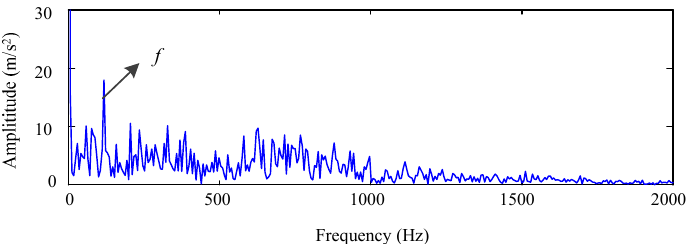
Figure 33. Envelope spectrum of optimal component of challenging signal by using VMD.